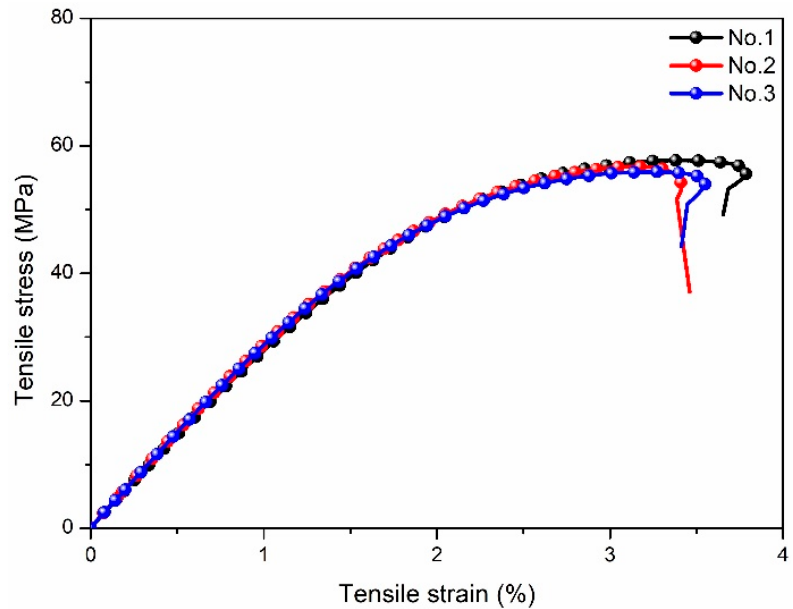
Figure 1. Tensile stress-strain curves of Ts resin.